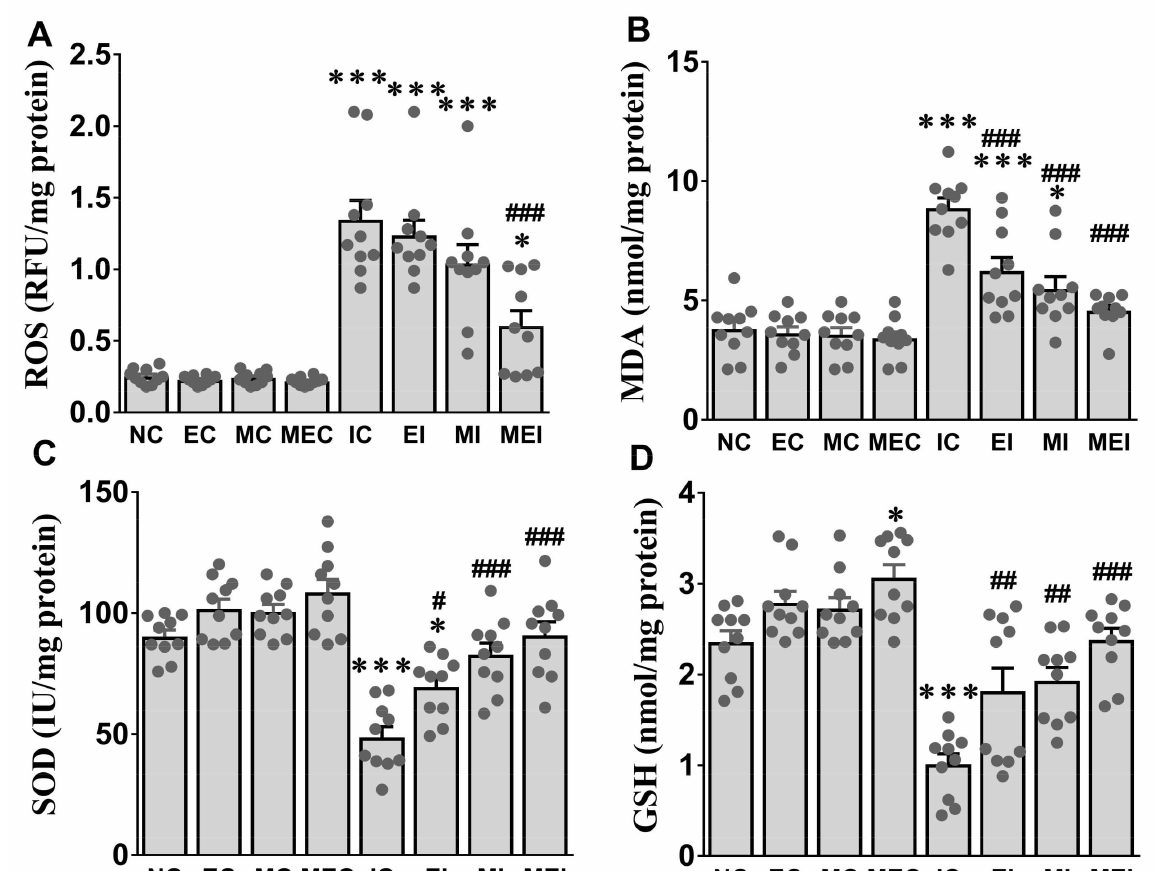
Figure 2. Effect of melatonin and exercise on cardiac oxidative stress-related markers in isoproterenol- challenged rats. ( A ) ROS, reactive oxygen species; ( B ) MDA, malondialdehyde; ( C ) SOD, superoxide dismutase; ( D ) GSH, glutathione. The data are reported as the mean ± SEM ( n = 10). * p < 0.05 and *** p < 0.001 versus the NC group. # p < 0.05, ## p < 0.01, and ### p < 0.001 versus the IC group calculated through one-way ANOVA followed by the post hoc Bonferroni test. NC, normal control; EC, exercise control group; MC, melatonin control group; MEC, melatonin plus exercise control group; IC, isoproterenol control group; EI, exercise plus isoproterenol-challenged group; MI, melatonin plus isoproterenol-challenged group; MEI, melatonin and exercise plus isoproterenol-challenged group. ROS, reactive oxygen species; MDA, malondialdehyde; SOD, superoxide dismutase; GSH,